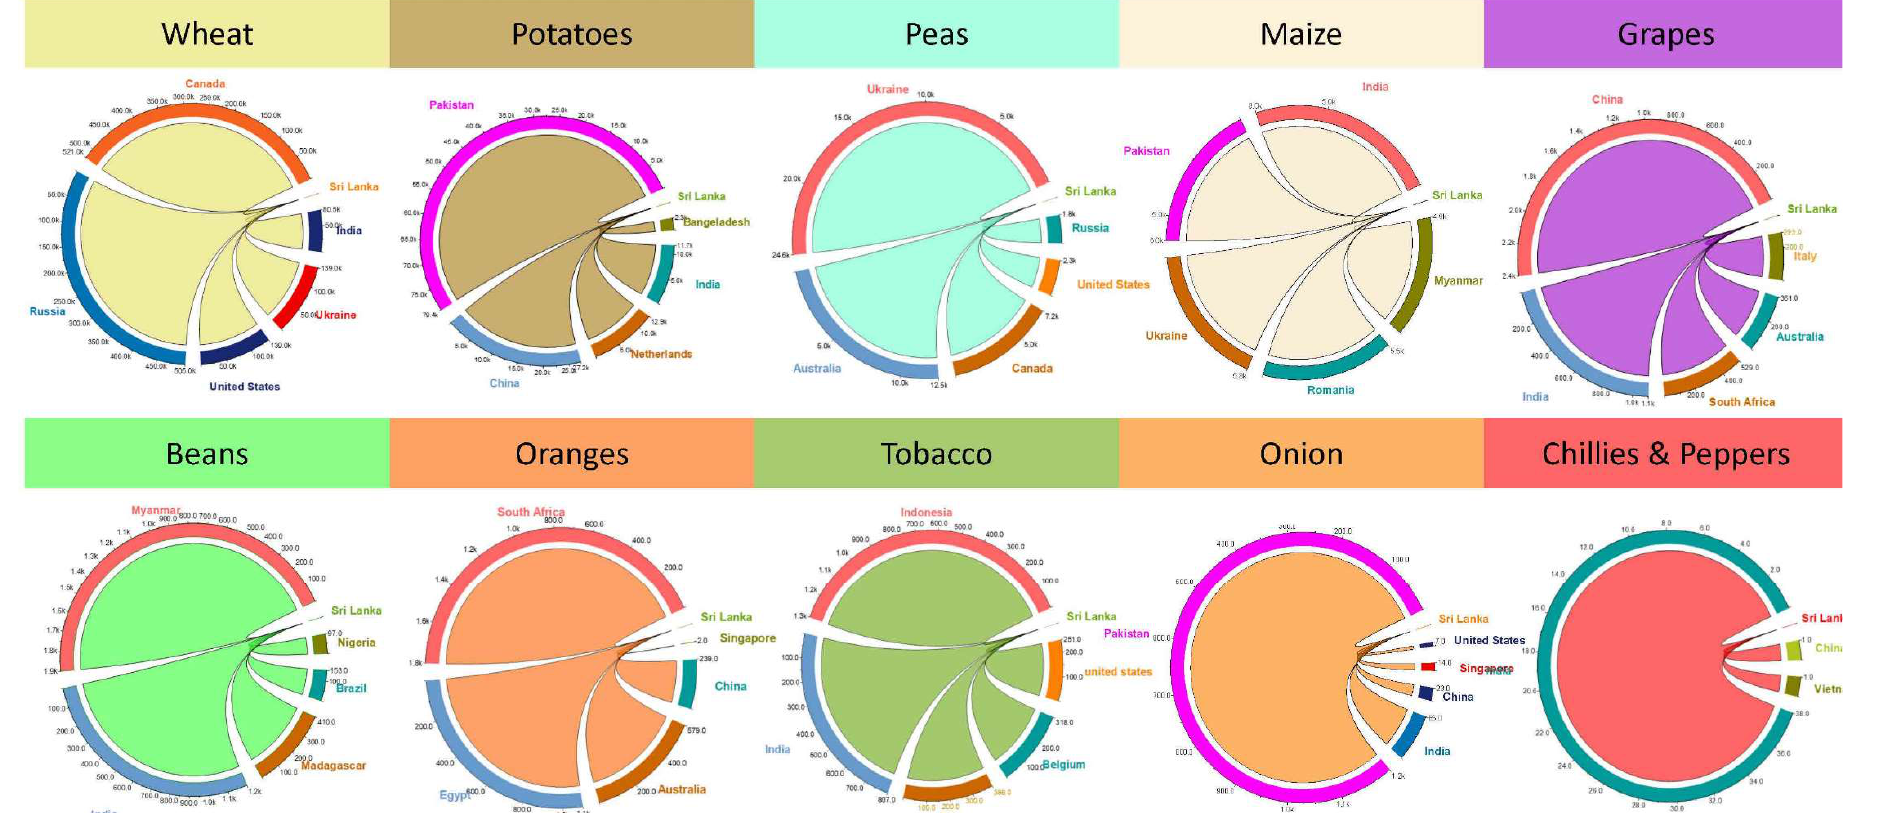
Figure 8. Imports in 2020 with details of countries for each top import